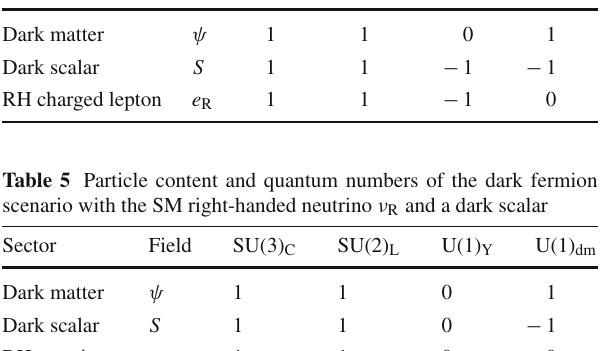
Table 3 Particle content and quantum numbers of the dark fermion scenario with the SM lepton doublet L and a dark scalar